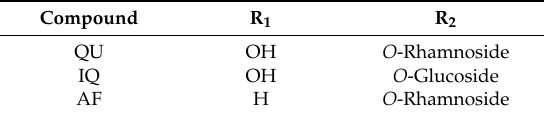
Figure 8. The structures of flavonoids from Acer okamotoanum. Table 1. The Flavonoids from Acer okamotoanum